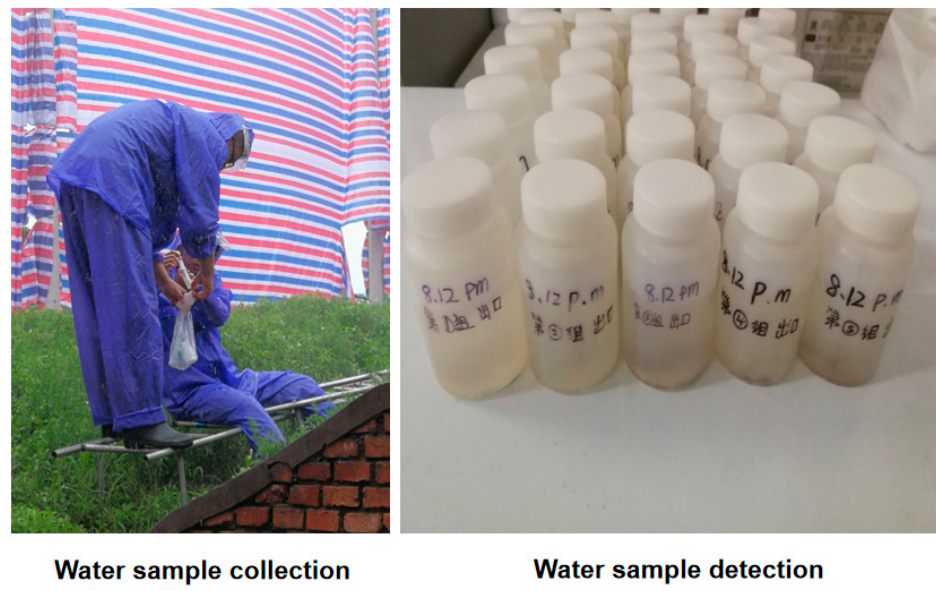
Figure 7. Water sample collection and detection.